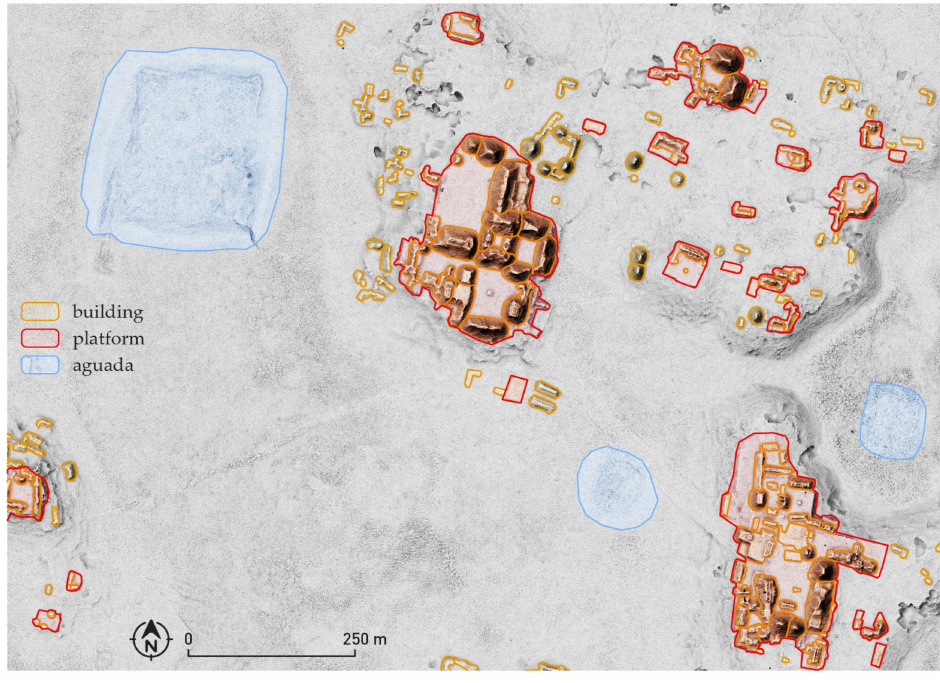
Figure 3. Chact ú n core area with annotated structures.